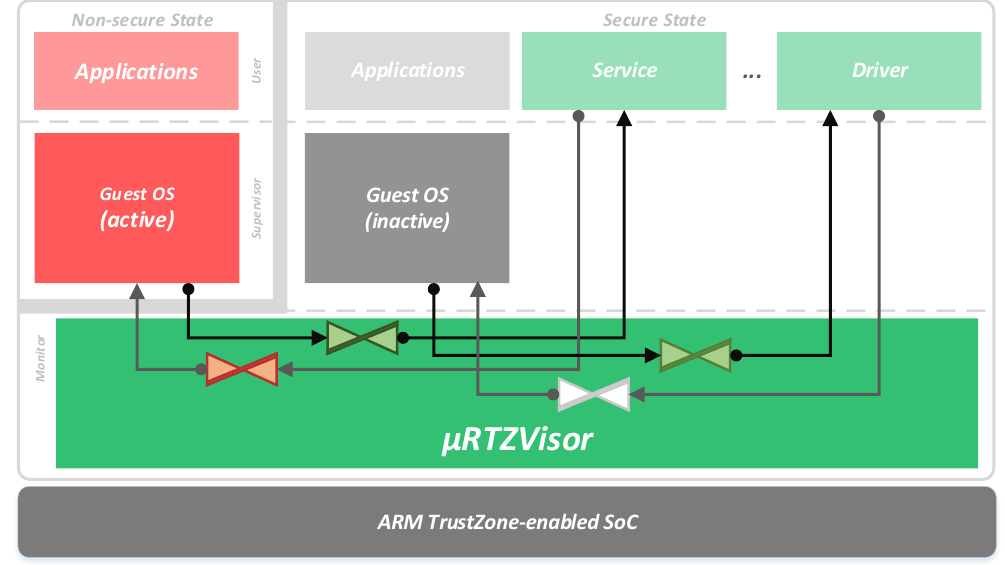
Figure 2. µ RTZVisor architectural